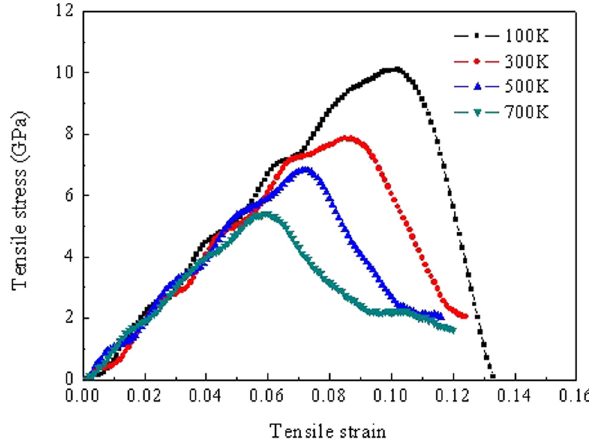
Figure 7: Stress – strain curves of the Cu ( 111 ) /Al 2 Cu ( 1¯ 10 ) /Al ( 111 ) model at di ff erent temperatures.